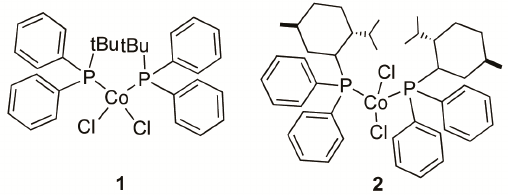
Figure 1. Bis-diphenylphosphine cobalt complexes used in this work.